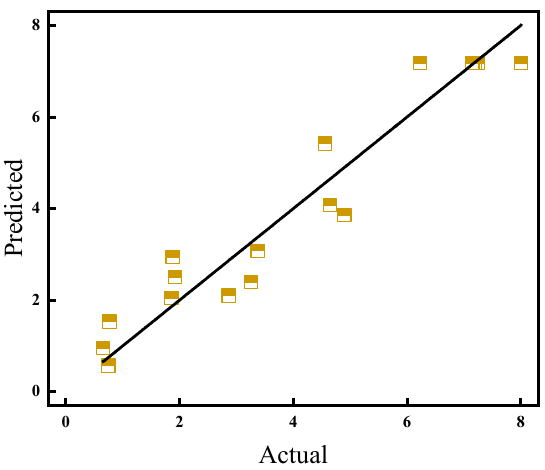
Figure 6. Comparison of predicted and measured values.